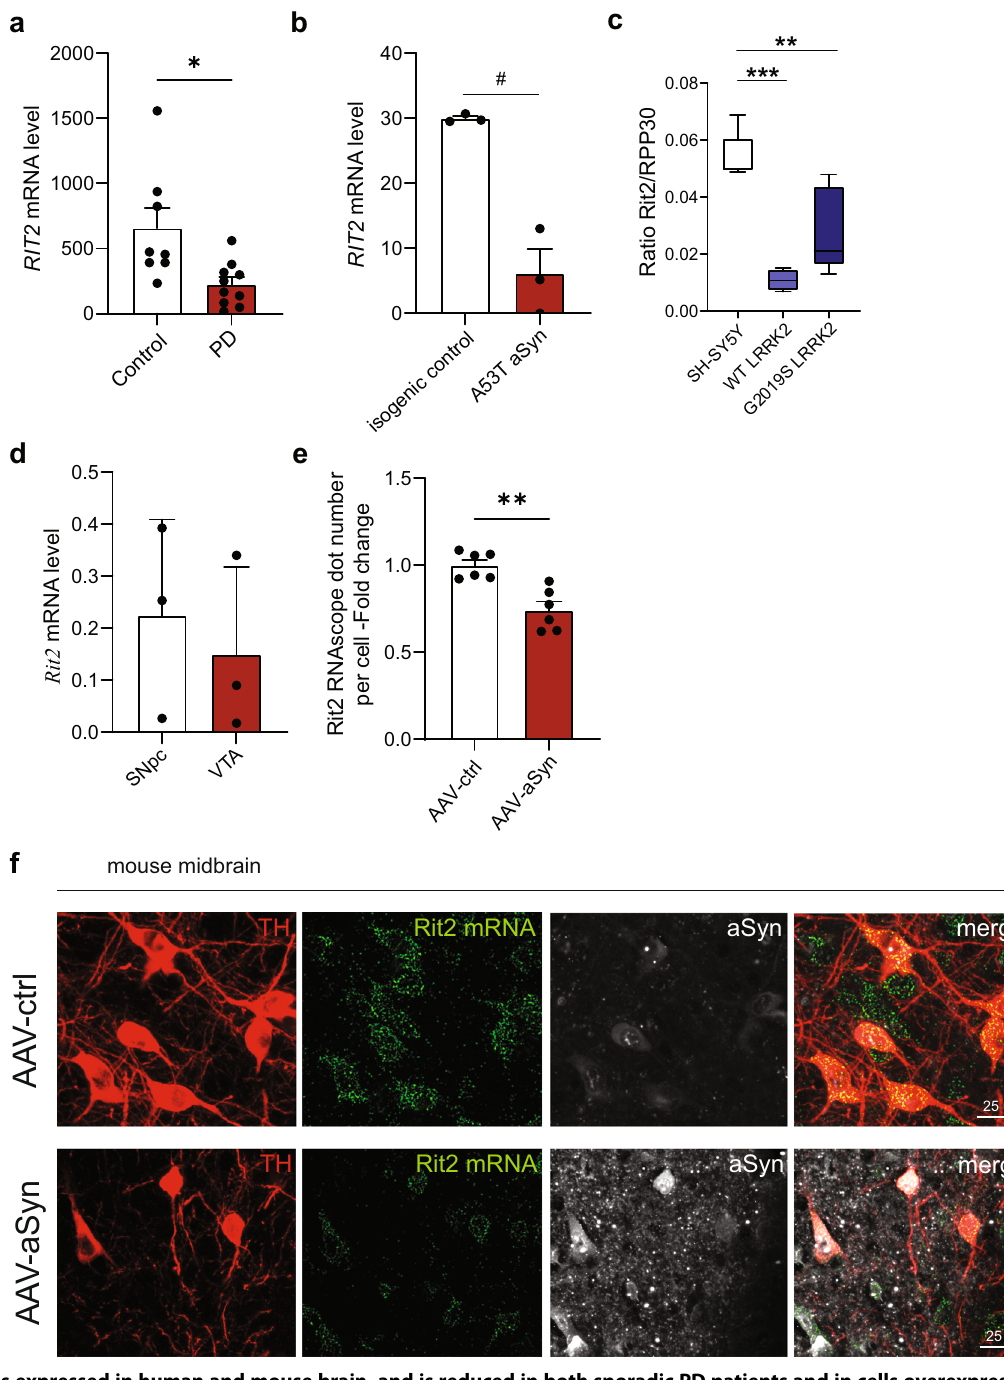
Fig. 1 Rit2 is expressed in human and mouse brain, and is reduced in both sporadic PD patients and in cells overexpressing LRRK2. a Geo dataset comparing RIT2 expression levels in DA neurons of the SNc isolated by laser capture microdissection. mRNA levels were reduced by 2.2-fold in DA neurons from sporadic PD patients, when compared to healthy controls (GSE20141, controls = 8, PD = 10). b Geo dataset (GSE46798) comparing Rit2 expression in iPSC-derived DA neurons with A53T-aSyn mutation to control mutation-corrected neurons ( n = 3). c Droplet Digital PCR was carried out to assess RIT2 mRNA levels in recombinant neuroblastoma cell lines. Ratio of RIT2 mRNA, normalized to RPP30, is reduced in WT and G2019S-LRRK2 cells ( n = 3). d Geo dataset (GSE17542) comparing Rit2 expression in SNc and VTA from TH-GFP mice ( n = 3). e Quanti fi cation of Rit2 mRNA levels in dopaminergic neurons in the midbrain. Viral aSyn expression decreases Rit2 mRNA levels ( n = 6). f Fluorescent in situ hybridization (RNAscope ® ) was employed to show Rit2 mRNA expression in DA neurons of the mouse SNc and TH and aSyn staining were visualized using immunostaining. Data are represented as median, boxes show the IQ and whiskers show min – max or means ± SEM. * p < 0.05, ** p < 0.01 two-tailed Student ’ s t test. # p < 0.05 unpaired t -test with Welch ’ s correction after D ’ Agostino-Pearson test for normal distribution. ** p < 0.01, *** p < 0.001, one-way ANOVA followed by Bonferroni ’ s post hoc